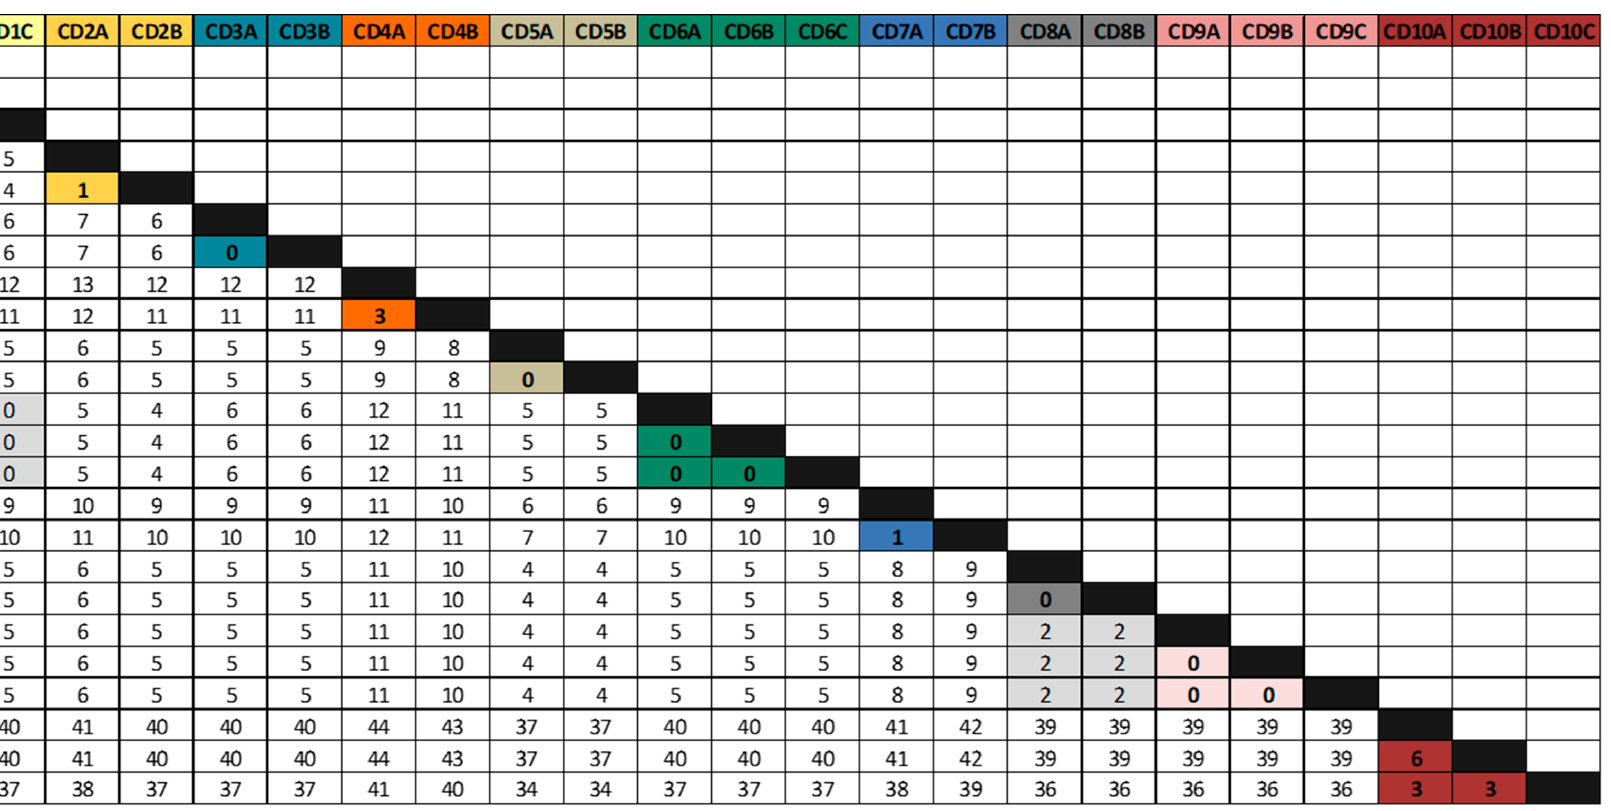
Figure 1. SNV comparative analysis within the different patient isolates. Overall, these results showed that all the recurrent episodes were due to isogenic strains with the initial ones, thus all these cases could be classified as relapses, with the exception of the first recurrent episode of patient CD10, where a related yet non-isogenic strain was found, wherefore, it could not be concluded whether a relapse or a reinfection had occurred in that case. Shaded squares point to SNVs within isolates of the same patient and within patients in which putative transmission events occurred.